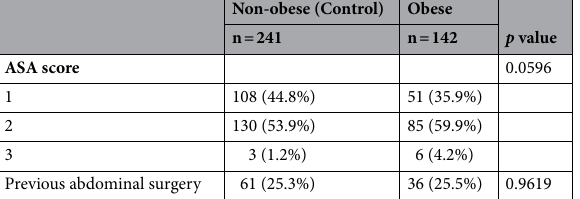
Table 3. Preoperative factors. ASA, American Society of Anesthetists-physical status.